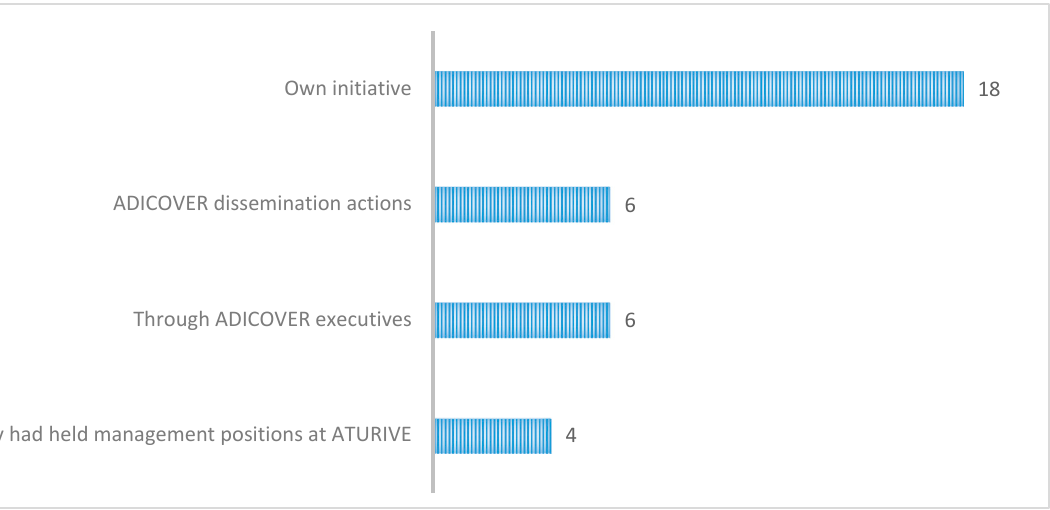
Figure 6. How did you find out about the existence of Proder aid? Source: Own elaboration .